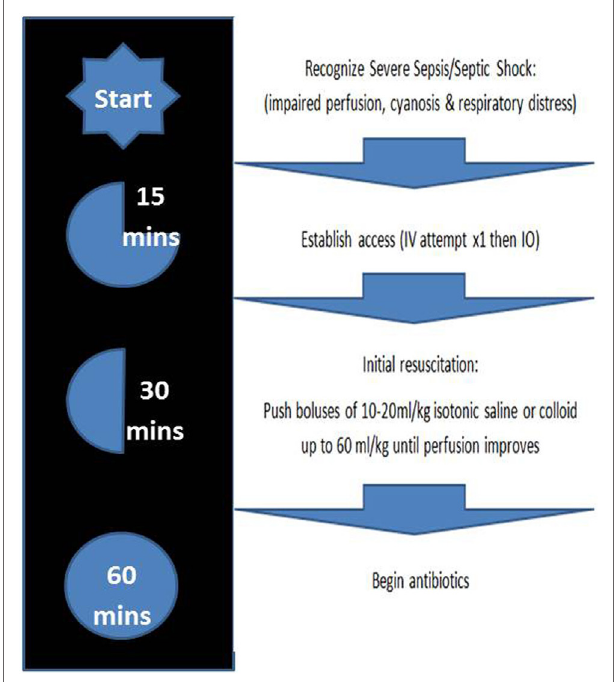
Figure 1 | Management of severe sepsis/septic shock based on 2015 Pediatric Advanced Life Support guidelines (4).